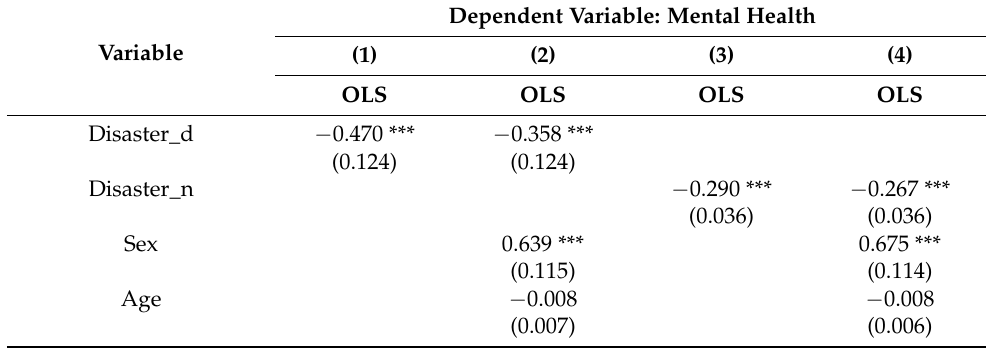
Table 3. OLS results of the effects of natural disasters on middle-aged and older adults’ mental health.